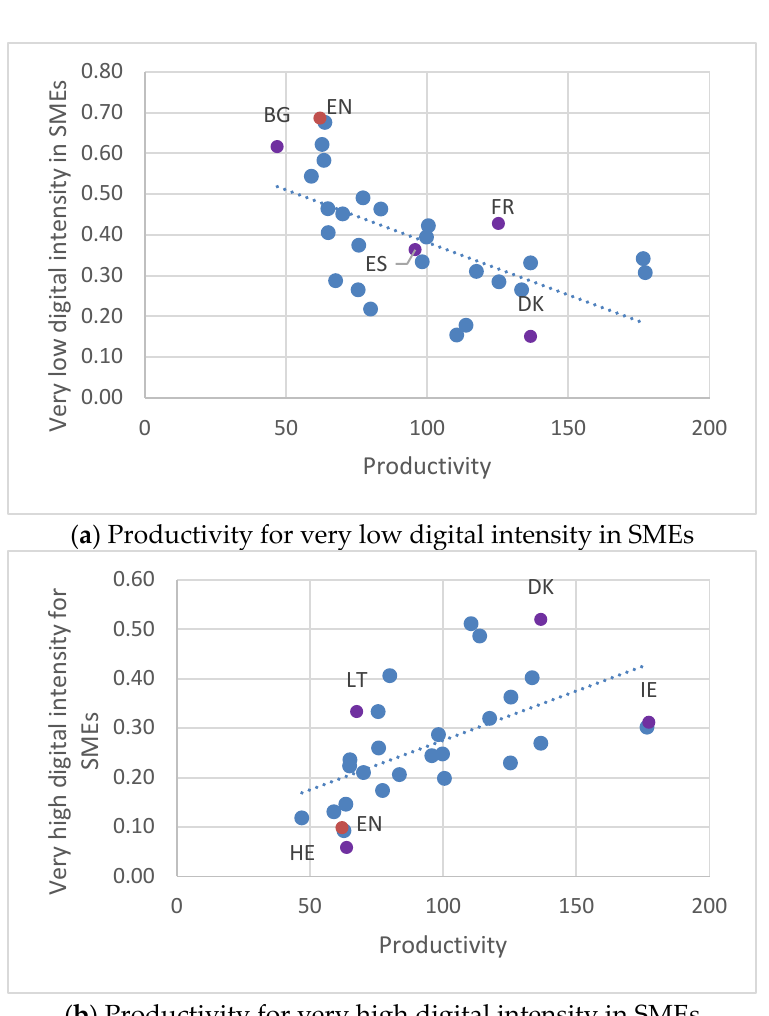
Figure 2. The relationship between digital intensity in SMEs and the level of productivity. Source: Processing based on data provided by Eurostat [16].